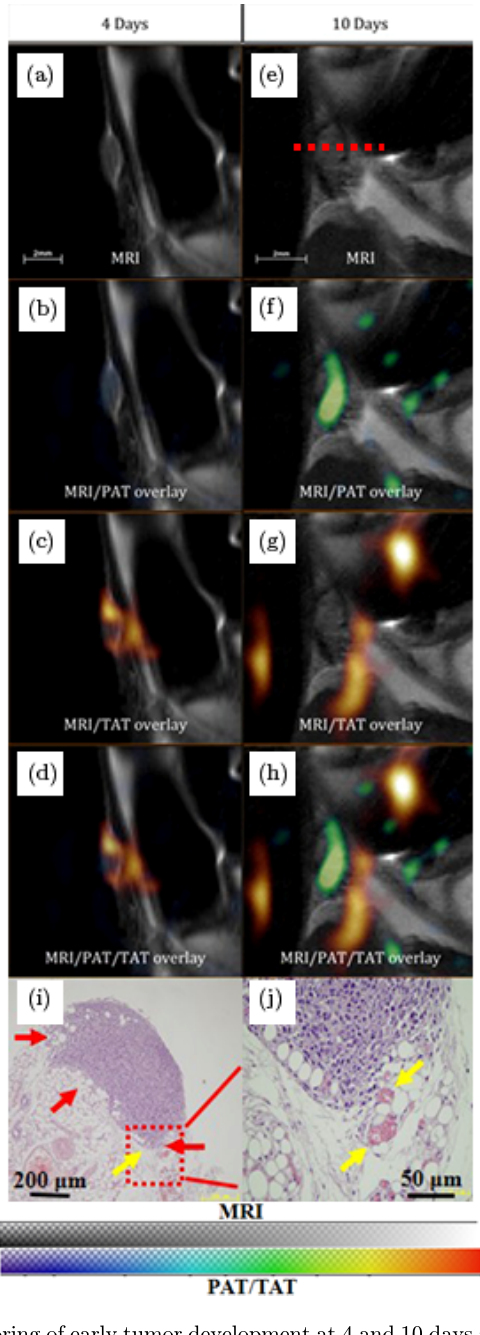
Fig. 2. Combined MR – PA – TA monitoring of early tumor development at 4 and 10 days after implantation of cancer cells. (a) – (d) and (e) – (h) represent local tumor MRI image (gray), MRI overlay with PAT image (green), MRI overlay with TAT image (orange), and triple-modality co-registered MR – PA – TA image, at 4 and 10 days following tumor cells injection, respectively. Scale bar ¼ 2 mm for (a) – (h). For histology analysis, the dashed red line [I, Fig. 2(e)] indicates the histology analysis cross-section, which shows the invasive growth of malignant tumor cells towards surrounding normal tissue (red arrow) where the tumor capsule integrity was destroyed at 10 days after the cancer cells implantation. At a higher magni¯cation in (j), the frontier cells of the tumor margin in¯ltrated into normal tissue, where the capillaries and microvessels (yellow arrow) became particularly intensive in order to satisfy the needs of tumor growth. The scale bar for (i) and (j) were 200 (cid:1) m and 50 (cid:1) m,